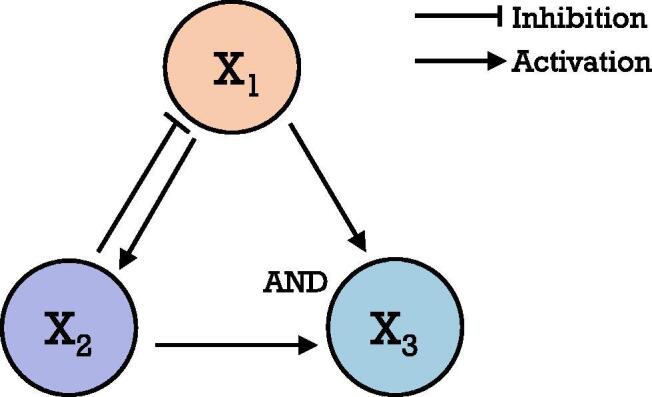
Three nodes network.